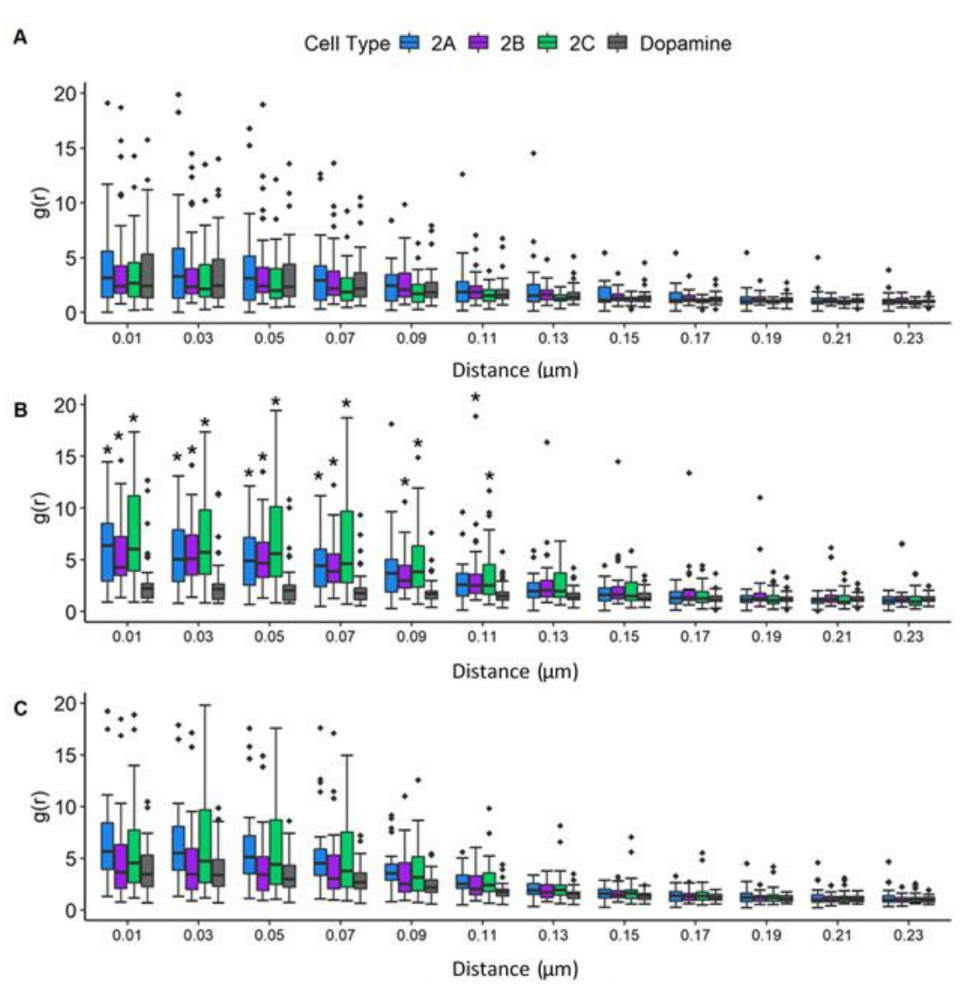
Figure 7. JCPyV aggregates significantly under 5-HT 2 R subtypes at 5 min post-infection. The radial distribution function (RDF) was analyzed to determine the spatial distribution of 5-HT 2 R- Dendra2, DRD2-Dendra2, and JustDendra2 (control) clusters at ( A ) 0, ( B ) 5, and ( C ) 15 mpi using widefield FPALM images. The Kruskal-Wallis test was used to compare the RDF values at each distance measured in each cell comparing all cell types across each timepoint. The symbol * indicates significant differences ( p < 0.01). The RDF value ( y -axis) denotes the density of molecules as a function of distance from the cluster center (r, x -axis), with an RDF value of 1 indicating the density expected for a random distribution. Populations represent ~30 cells per time point per sample from three independent experiments, representative of an average of three independent replicates. Outliers are represented by black